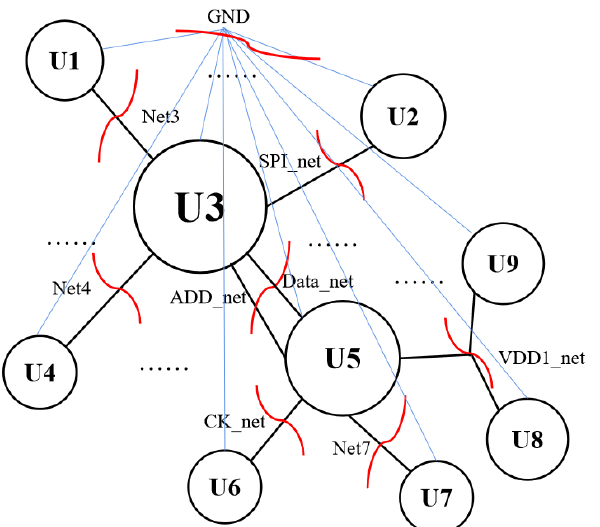
Figure 4. Schematic diagram for initial partitioning by cutting important attribute networks, better viewed in